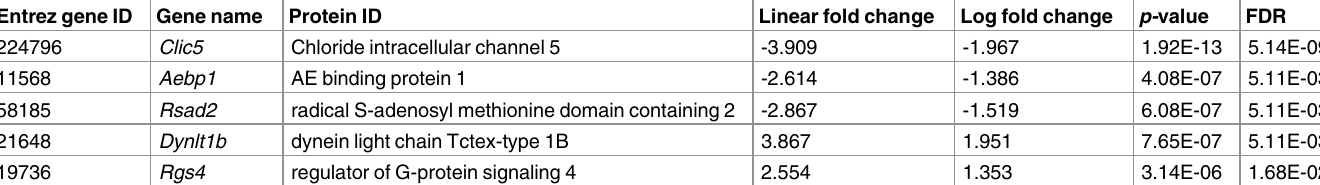
Table 1. List of genes with altered abundance in Cryaa -R49C-het mouse lenses.